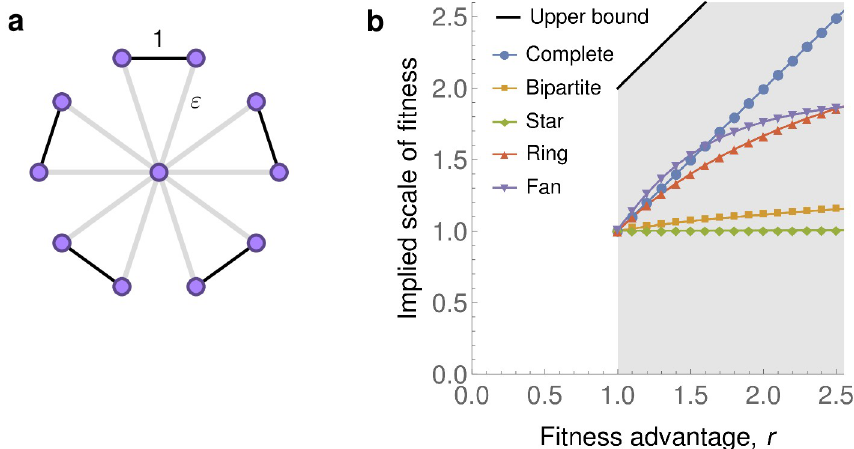
Fig 4. Transient amplifiers under death-Birth updating. A companion work [38] identified certain weighted graphs that are transient dB-amplifiers. a , The Fan graph F with N blades is a weighted graph obtained from a Star graph N , ε S 2 N +1 by pairing up the 2 N leaves and rescaling the weight of each edge coming from the center to ε < 1. b , The implied scale of fitness of a large Fan (here N = 101 and ε = 10 − 5 , values computed by numerically solving the underlying Markov chain). If r is small enough then the Fan amplifies selection under dB updating. The level of amplification is well within the scope allowed by Theorem 2 (shaded region). For comparison, we again show the implied scale of fitness for the Complete, Bipartite, Star, and Ring graphs ( N =